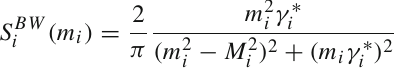
Fitting the entropy density on the lQCD data, the constant c is fixed to c = 14 . 4. The spectral function associated to light quark and gluon in the plasma are expressed